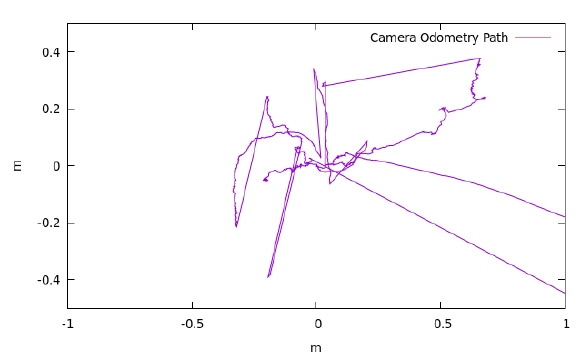
Figure 9. Tracking path for free movement with calibrated